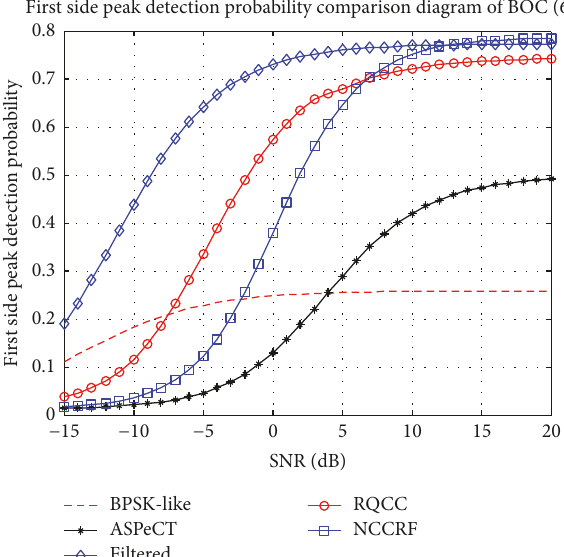
Figure 18: The SPDR comparison of BOC ( 6, 1 ).